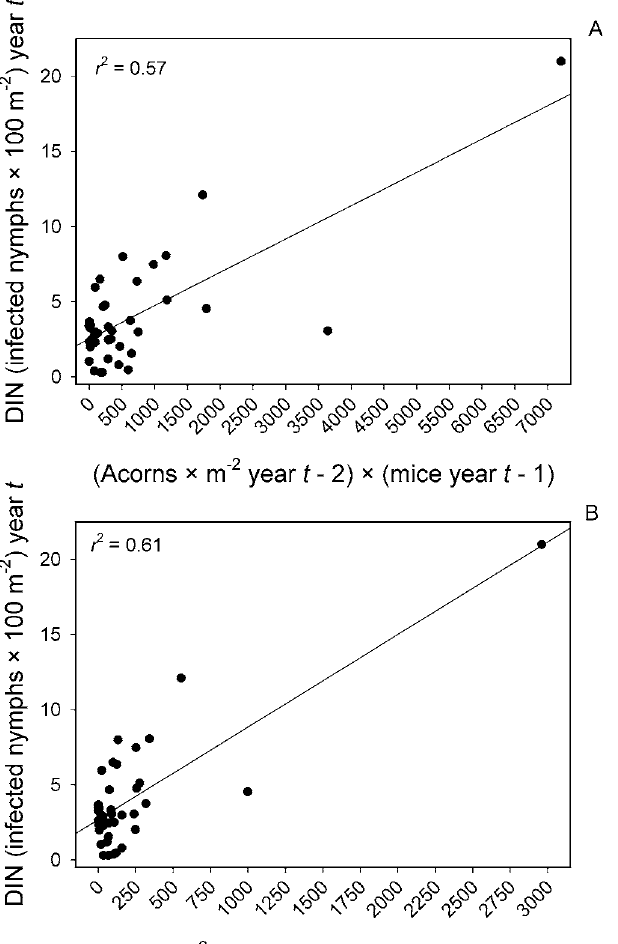
Figure 4. Effects of Acorn and Rodent Densities on DIN (A) Effects of the product of acorn density (acorns per square meter) in year t (cid:1) 2 and mouse (P. leucopus) density (number per 2.25-ha grid) in year t (cid:1) 1 on the density of B. burgdorferi -infected nymphs (number per 100 m 2 ) in year t. This regression model for DIN had the most support. (B) Effects of the product of acorn density (acorns per square meter) in year t (cid:1) 2 and chipmunk (T. striatus) density (number per 2.25-ha grid) in year t (cid:1) 1 on the density of B. burgdorferi -infected nymphs (number per 100 m 2 ) in year t. This regression model for DIN had nearly as much support (AIC corr ) as the mouse model (A) and a higher r 2 value. DOI: 10.1371/journal.pbio.0040145.g004